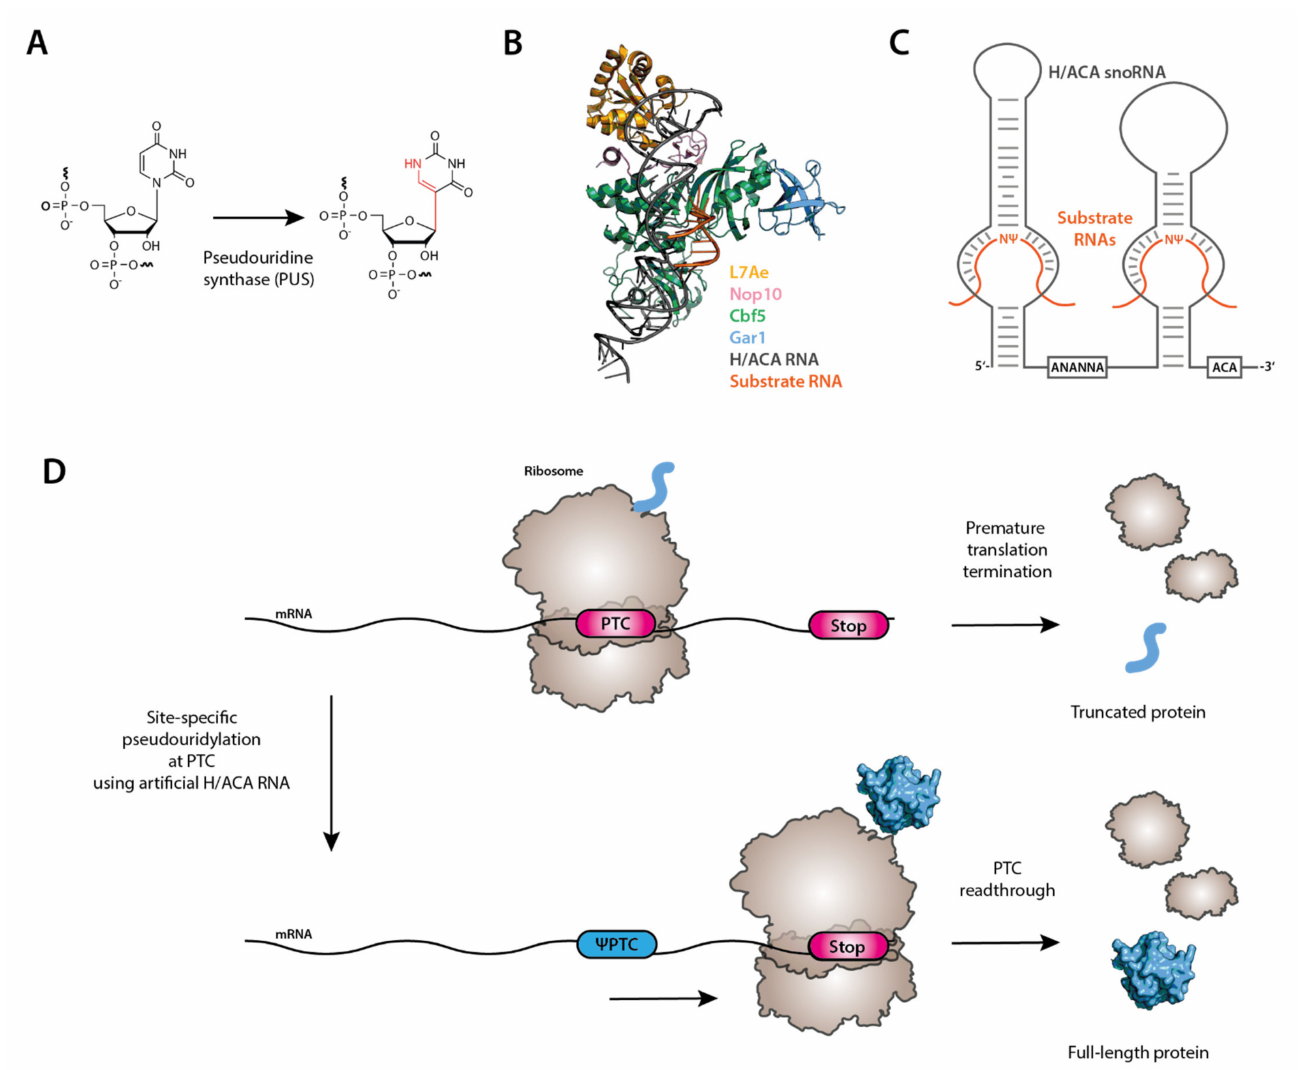
Figure 6. ( A ) Schematic of the conversion of U to Ψ catalyzed by standalone Pseudouridine synthase (PUS) or box H/ACA RNP. ( B ) Crystal structure of an archaeal substrate-bound full core box H/ACA snoRNP complex (PDB: 3HAY [200]). ( C ) Schematic description of the secondary structure of a eukaryotic box H/ACA snoRNA with substrate RNAs. ( D ) Site- specific pseudouridylation of stop codons results in ribosomal readthrough and allows for therapeutic correction of premature termination